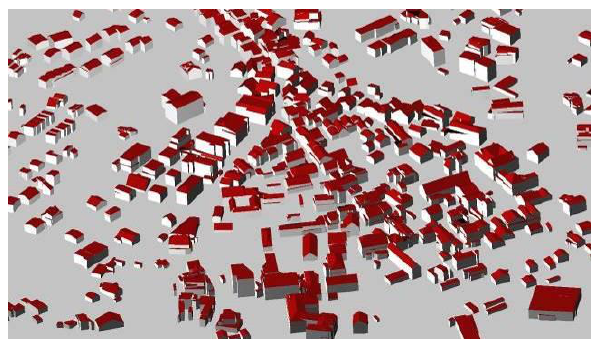
Figure 5. Visualization of 3D building models (LOD2) extracted from nadir + oblique images.